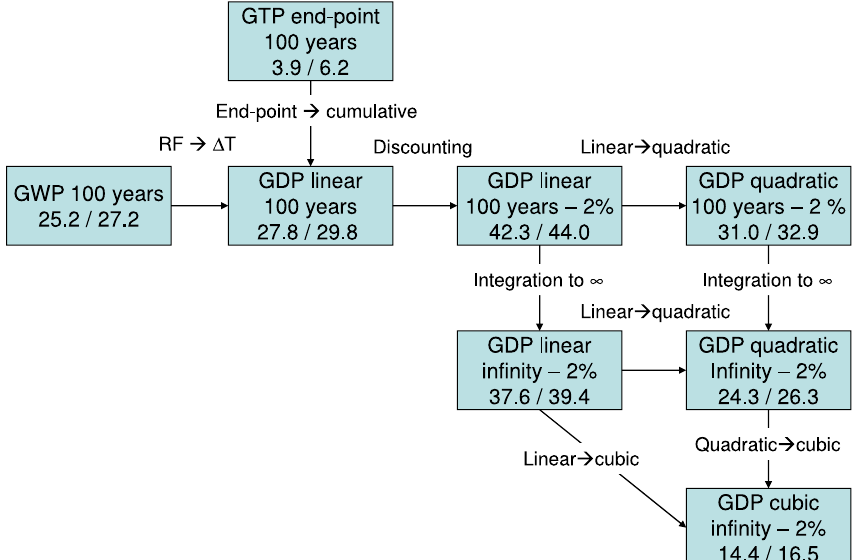
Fig. 1. Sensitivity of the methane CO 2 -equivalence (without/with the conversion of methane into CO 2 ) to the construction of the climate metric (see text for more